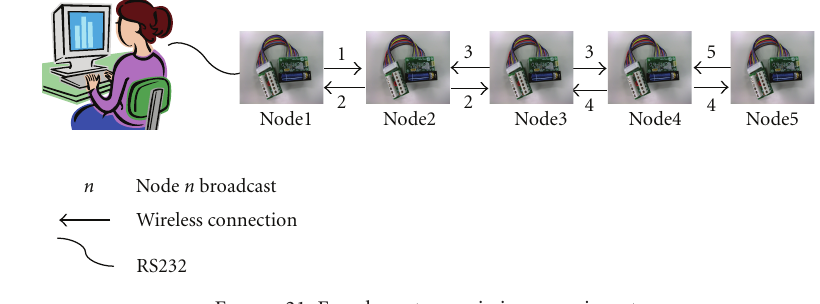
Figure 21: Four hops transmission experiment.